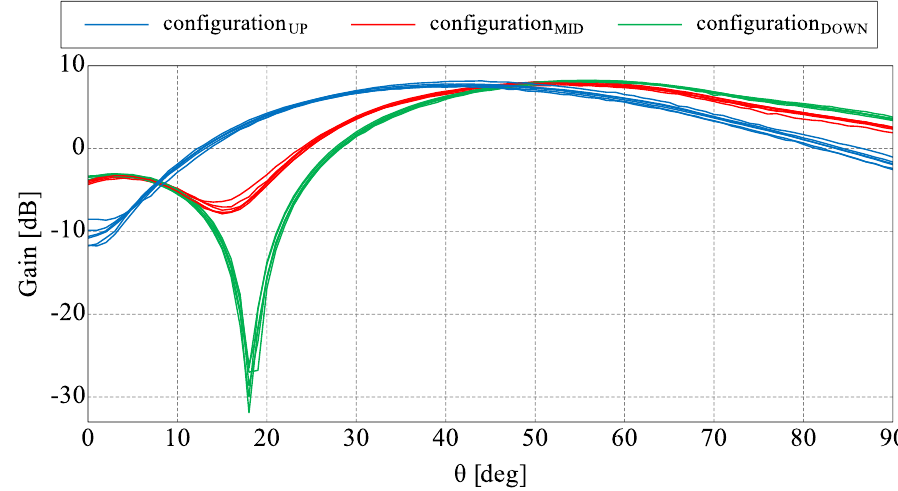
Figure 7. Measured radiation patterns in elevation plane for all directions.